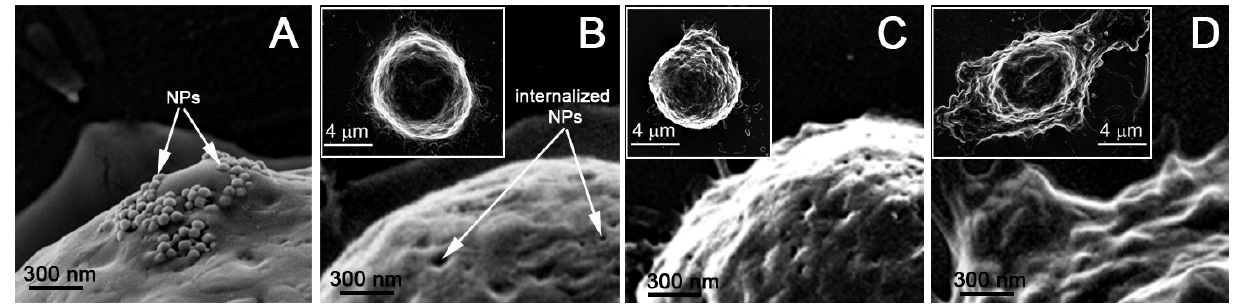
Figure 5. Scanning electron microscopy images of cancer cells after incubation with gold NPs show their membrane coupling ( a ) and internalization ( b ), and the result of the generation of a non-invasive PNB with a lifetime of 25 ± 5 ns ( c ) and an ablative PNB with a lifetime of 300 ± 42 ns ( d ) [96]. The insets show images of the whole cells. The cells were fixed immediately after being treated with